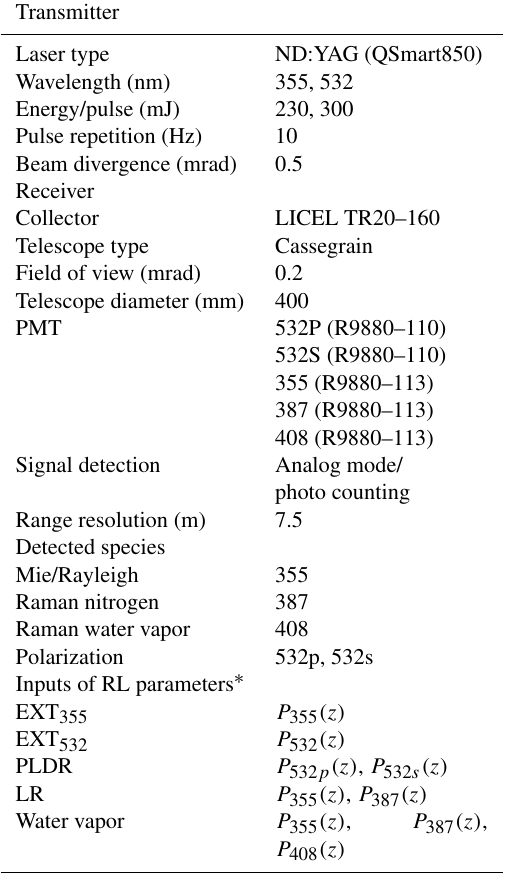
Table 1. Characteristics of the RL system.